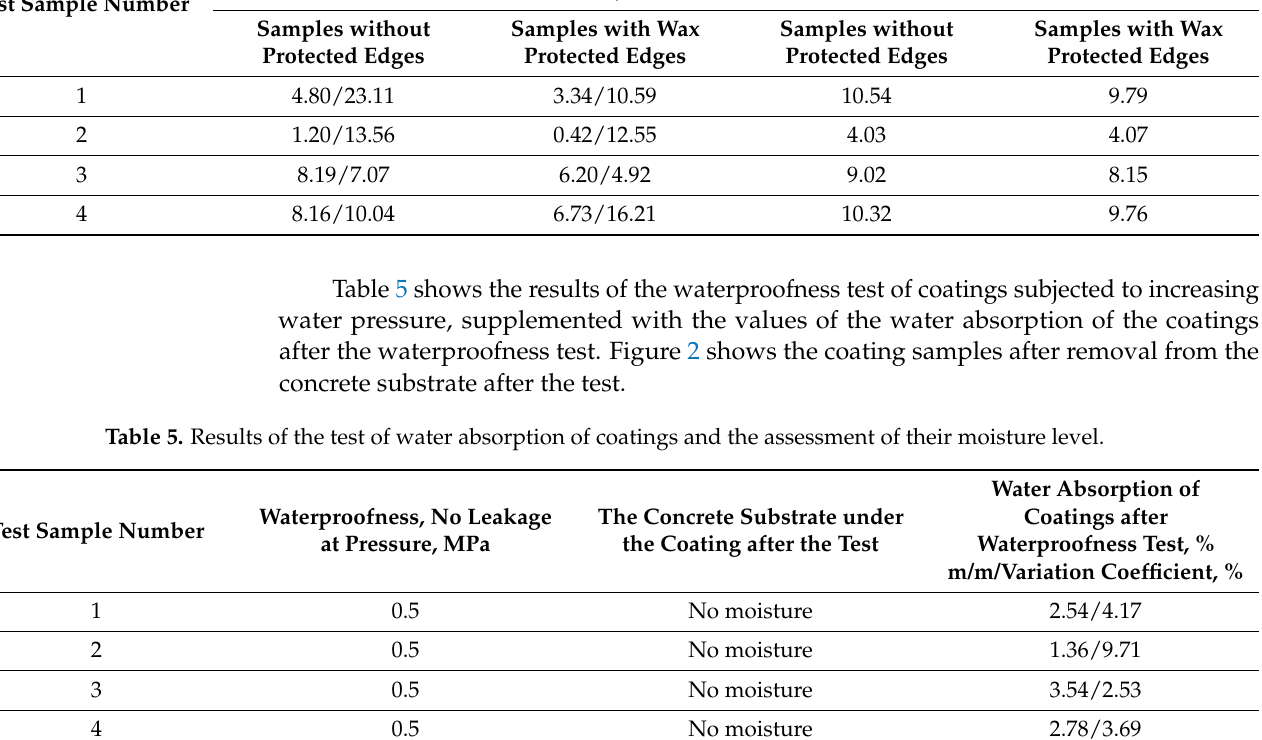
Test Sample Number